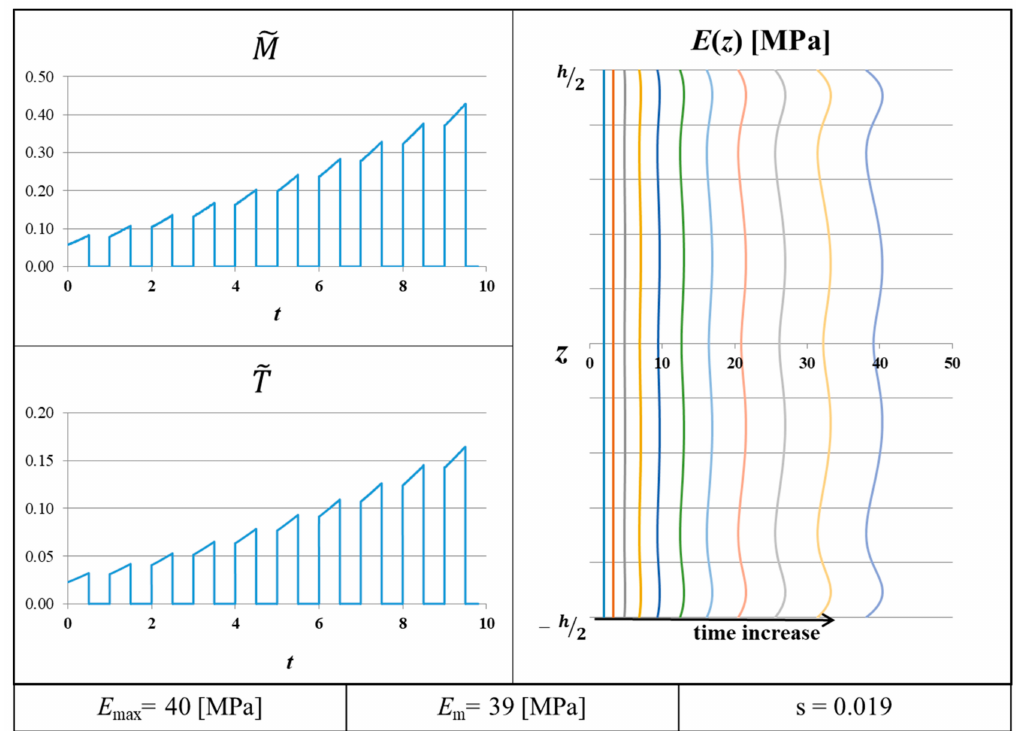
Figure 3. The intermittent loading program and the resulting in-time Young’s modulus distribution along the height of the analyzed rectangular section, with the parameters of the homogeneity.